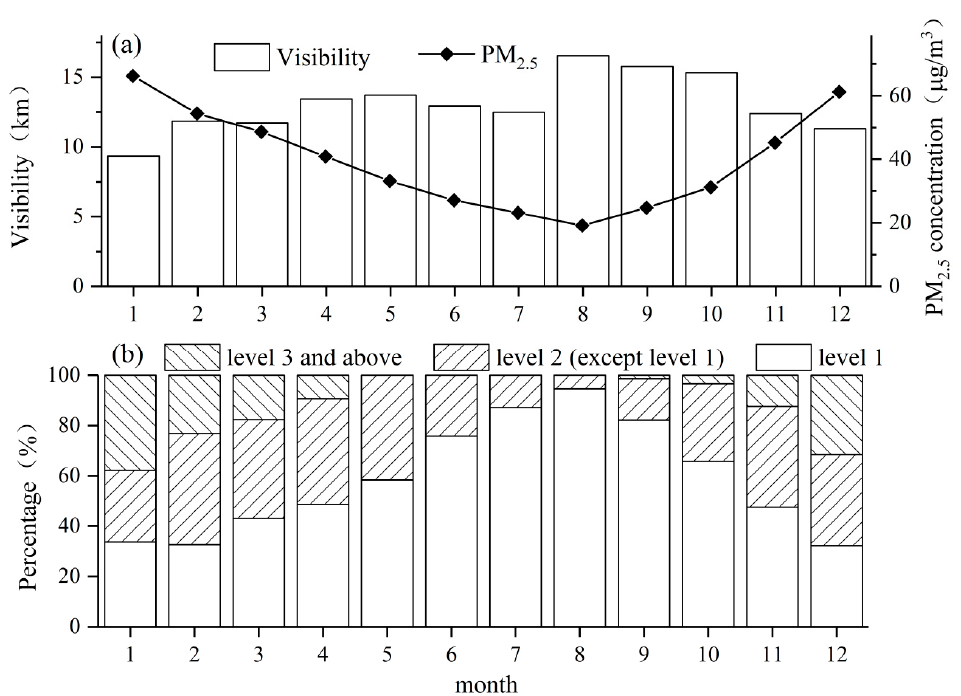
Figure 4. Monthly variation of PM 2.5 and visibility ( a ) and proportion of air quality levels in different months ( b ).